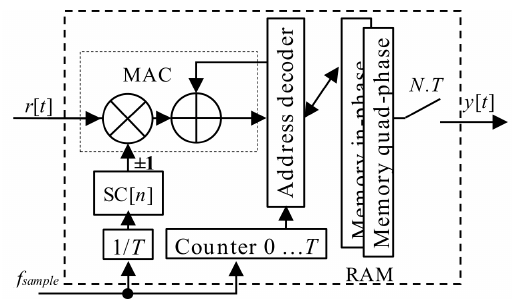
Figure 8. Block diagram of mPCA unit with MAC.